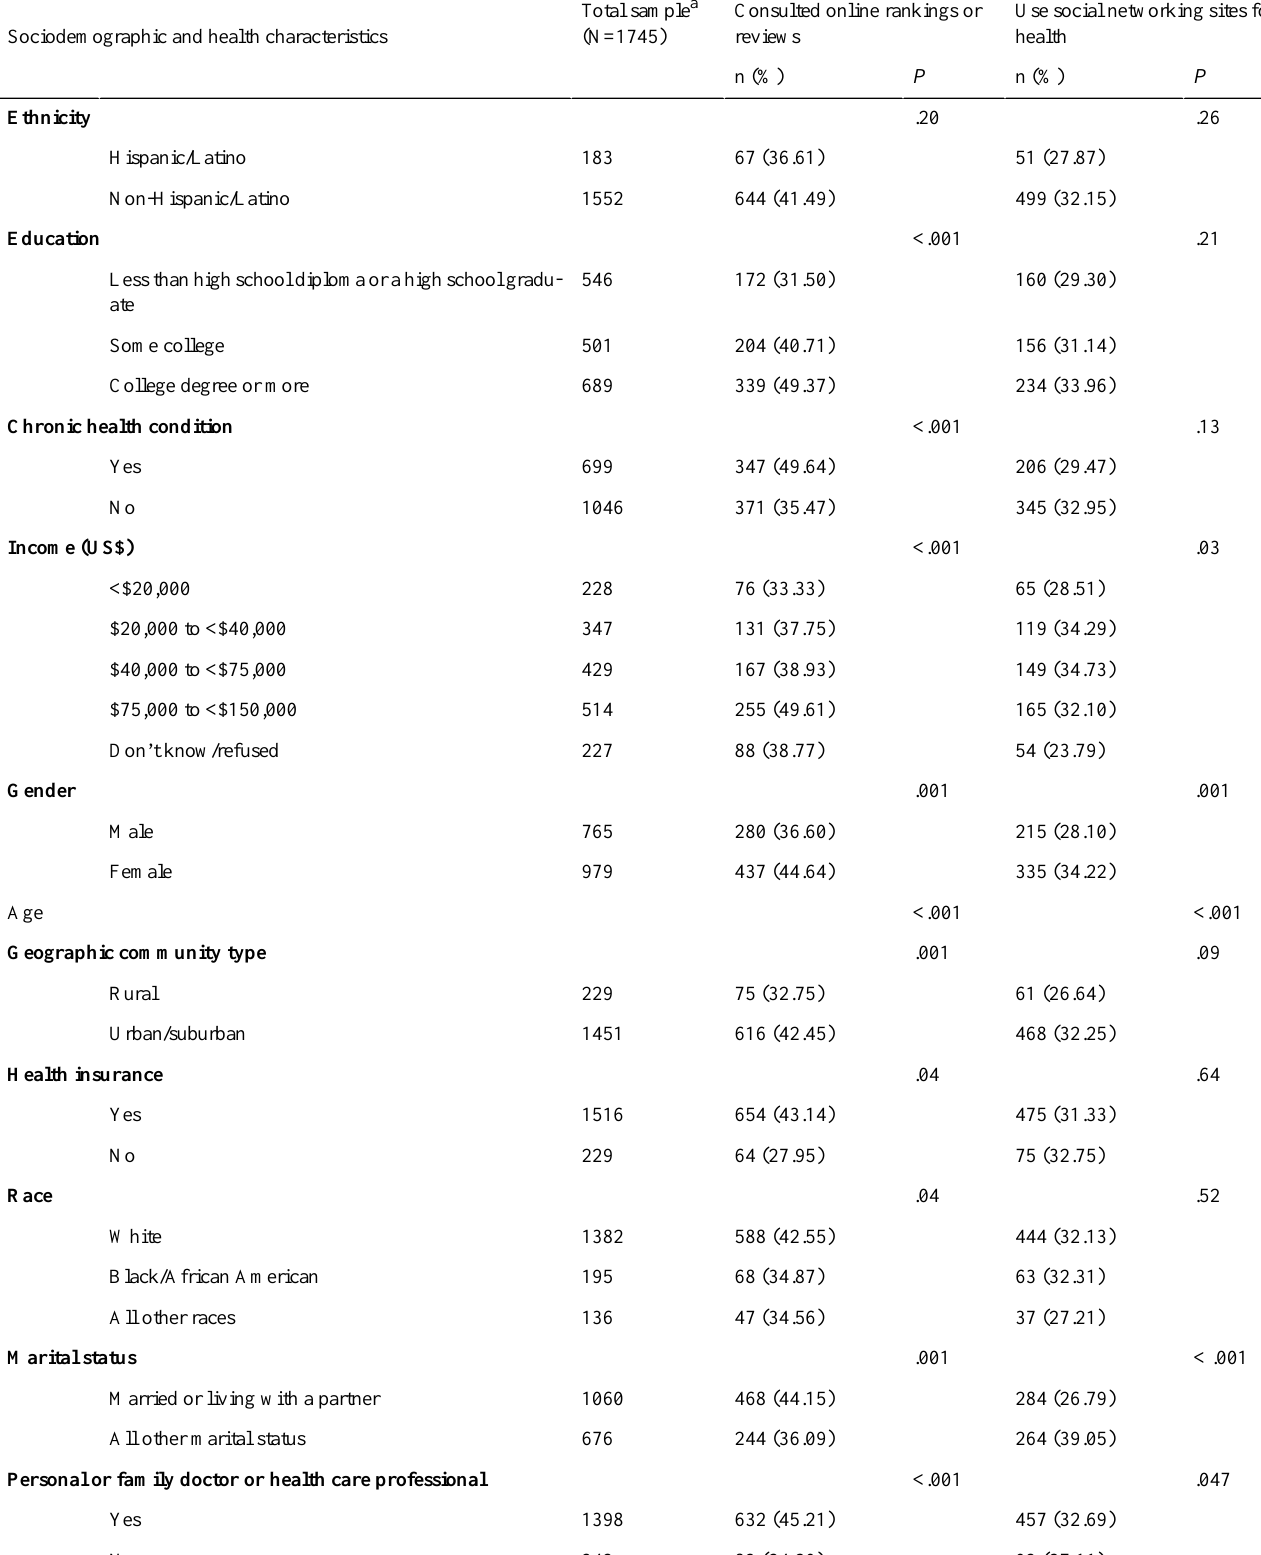
Table 2. Correlates of consulting online rankings or reviews (n=718) and use of social networking sites for health